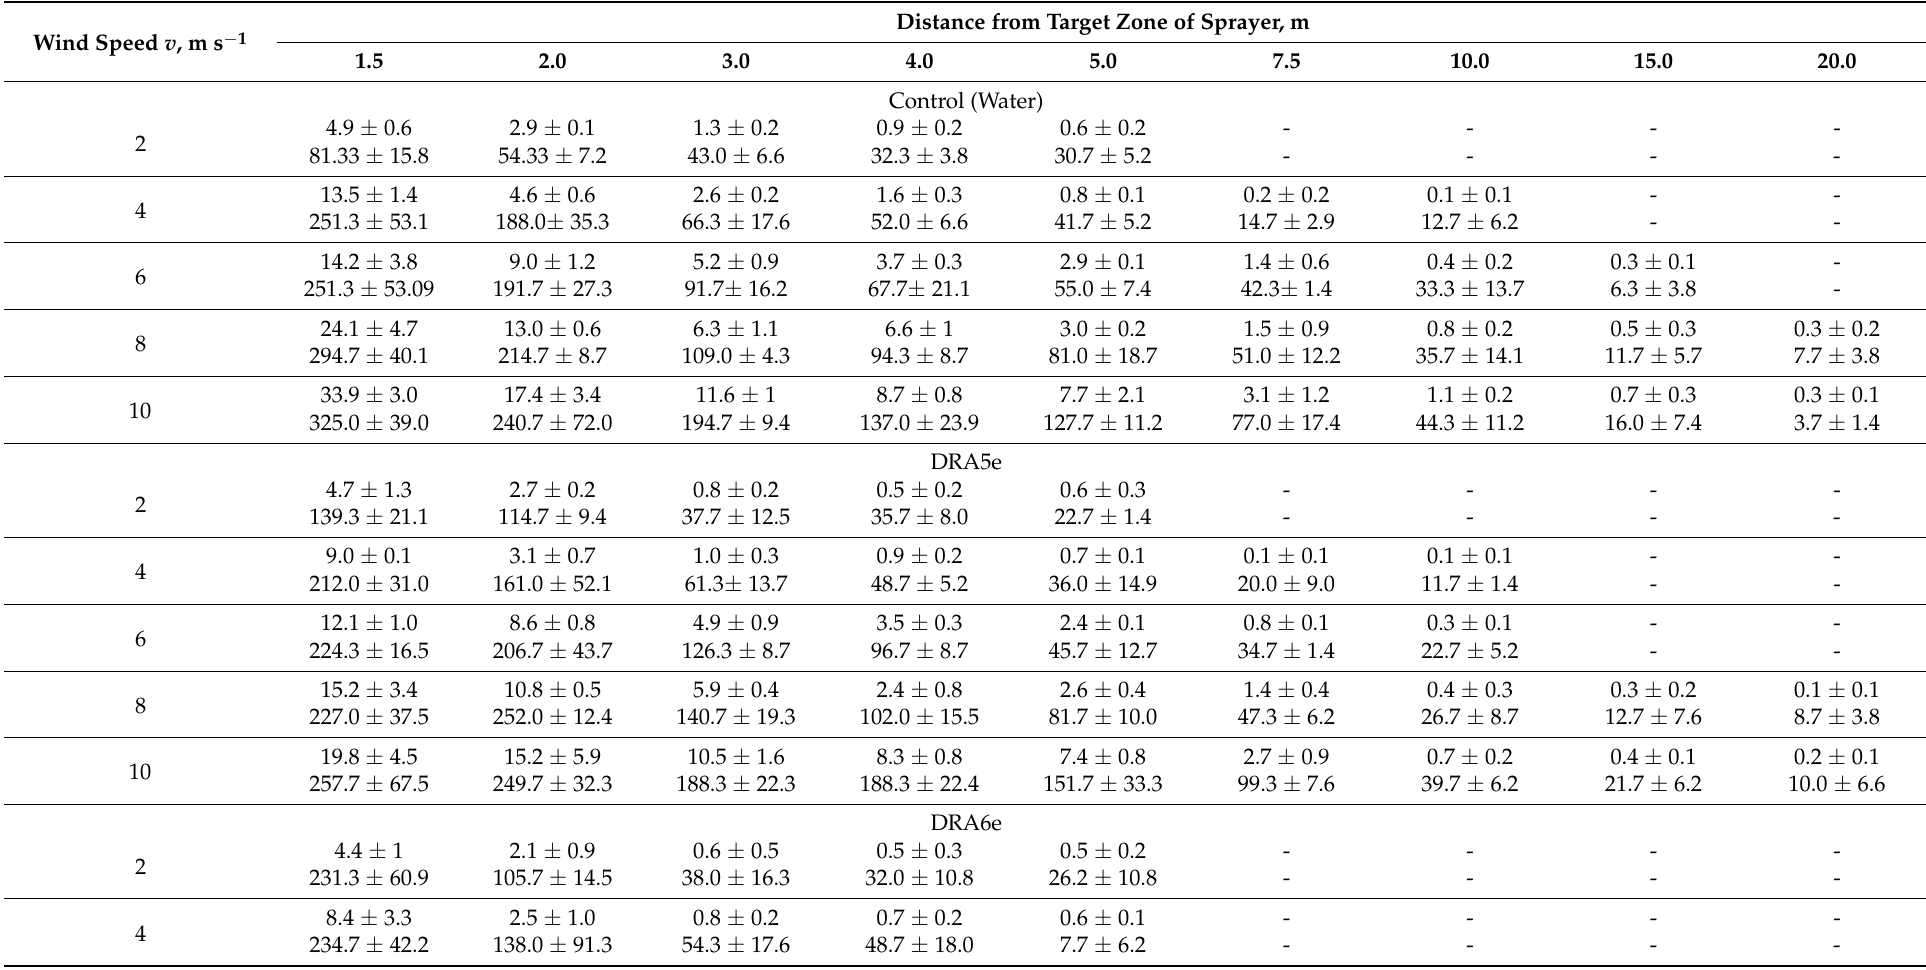
Table 4. Water-sensitive paper coverage (upper line, %) and number of droplets (lower line) when spraying with a sprayer with five air-injector flat spray nozzles, depending on the target zone of the